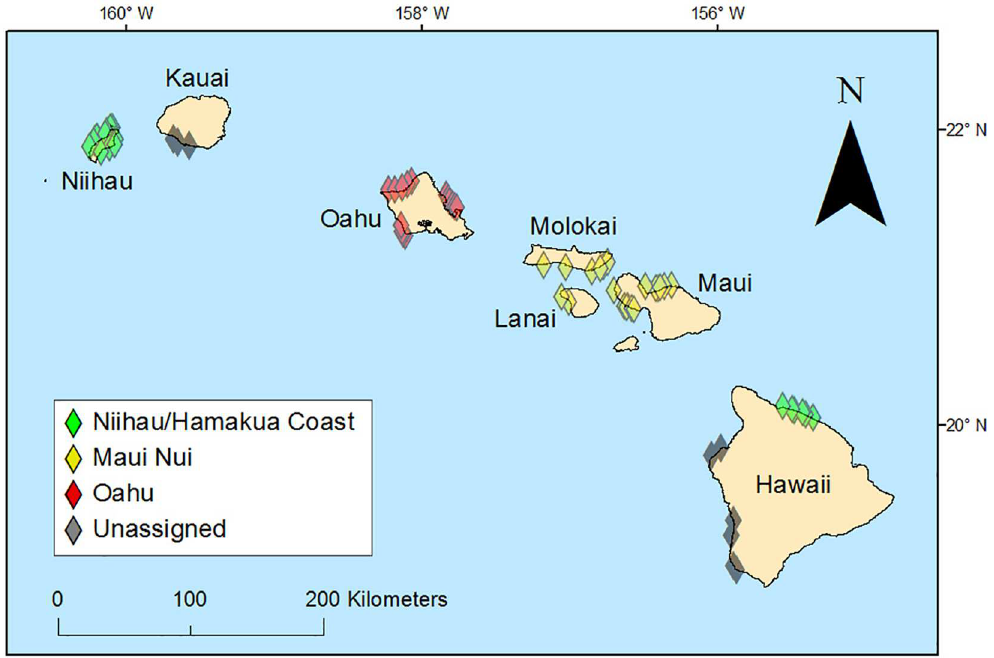
Fig 1. Map of survey locations. Diamondsmark locationsof pairedOC-CCR survey sites. The color of diamonds indicatepresumed fishingpressure with red = high, yellow = medium and green = low.